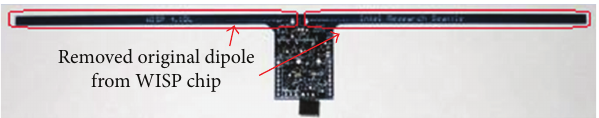
Figure 15: The original dipole is cut off from the WISP and the new folded microstrip antenna is connected to the balanced port in the centre. The length of the original dipole is 145 mm.